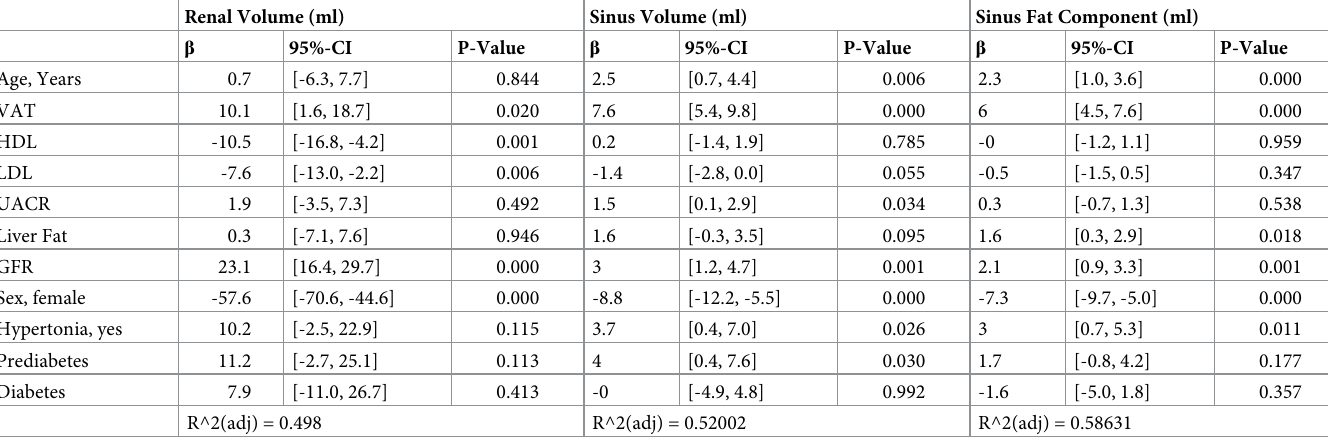
Table 3. Regression model with adjustments for age, VAT, HDL, LDL, urine albumin/creatinine, liver fat, GFR, gender, hypertension yes/no and glycemic status. Renal Volume (ml)